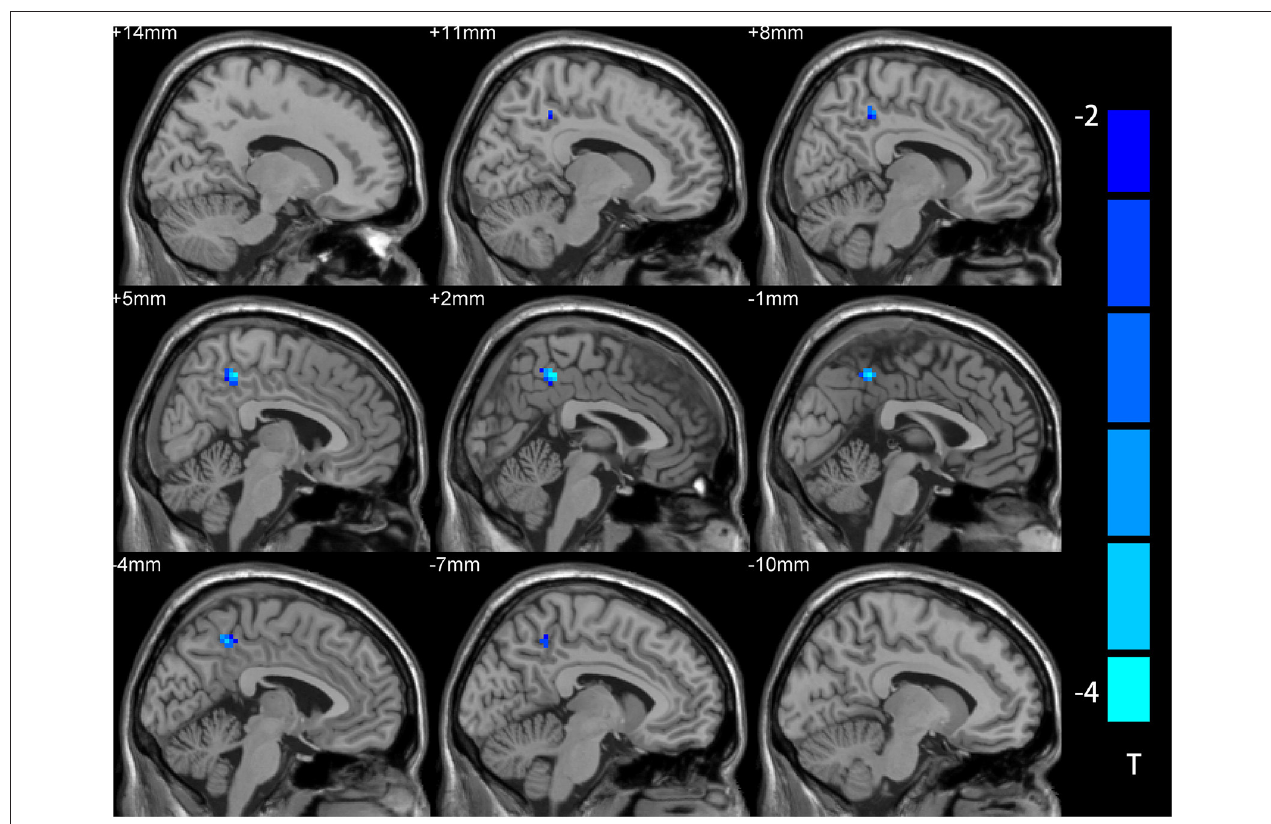
FIGURE 2 | NH differences between the MDD patient and NCs in statistical maps. NH is lower in the right precuneus (PCu) of the MDD patients. Blue represents lower NH; color bars correspond to the T values obtained from the two-sample t- test. NH, network homogeneity; MDD, major depressive disorder; NC, normal controls; PCu,